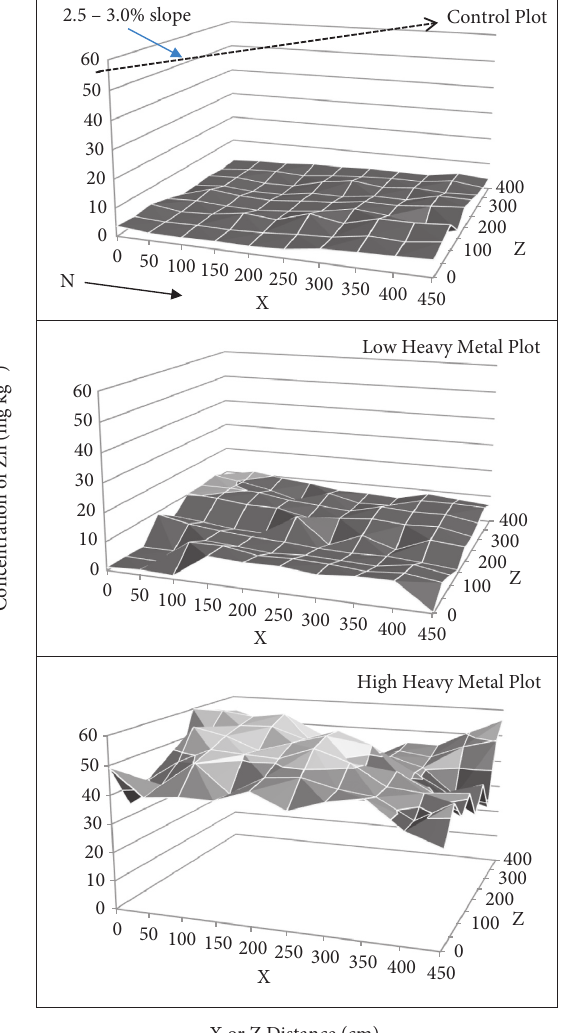
Figure 10: The horizontal spatial distribution of Zn in the waste-treated plots 21 years after amendment (control plot � 0, low metal plot � 15, and high metal plot � 60Mg waste ha − 1 ; plots measured 450cm ( X ) x 400cm ( Z